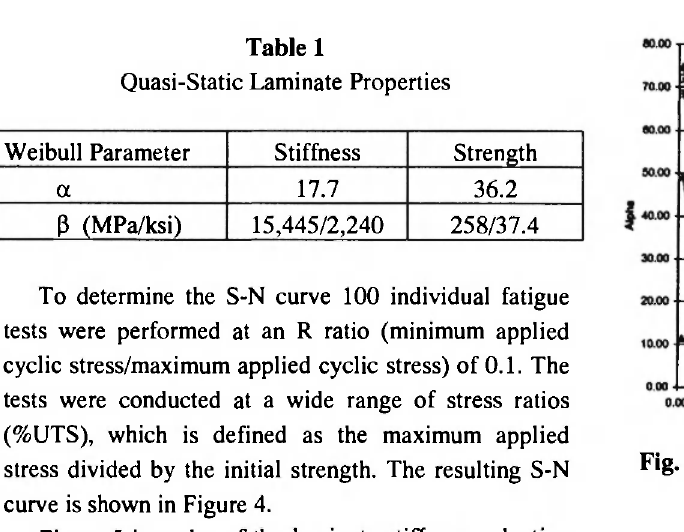
Modeling results